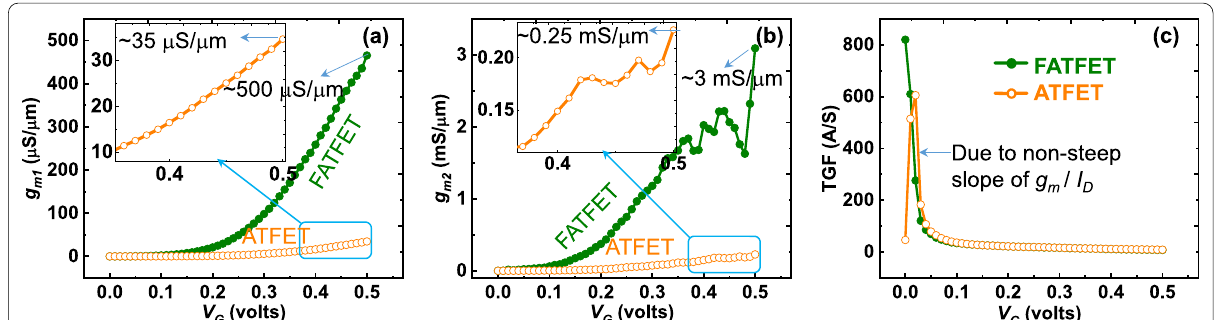
Fig. 9 Linearity behavior with a g m 1 , b g m 2 , and c TGF of FATFET and ATFET, respectively. Compared to ATFET, FATFET has a higher transconductance and less distortion